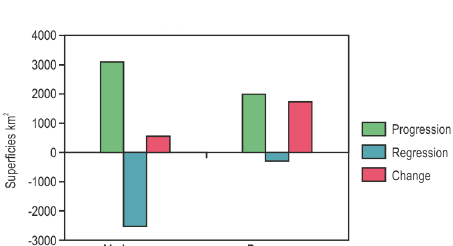
Fig. 4. Quantities of changes of land